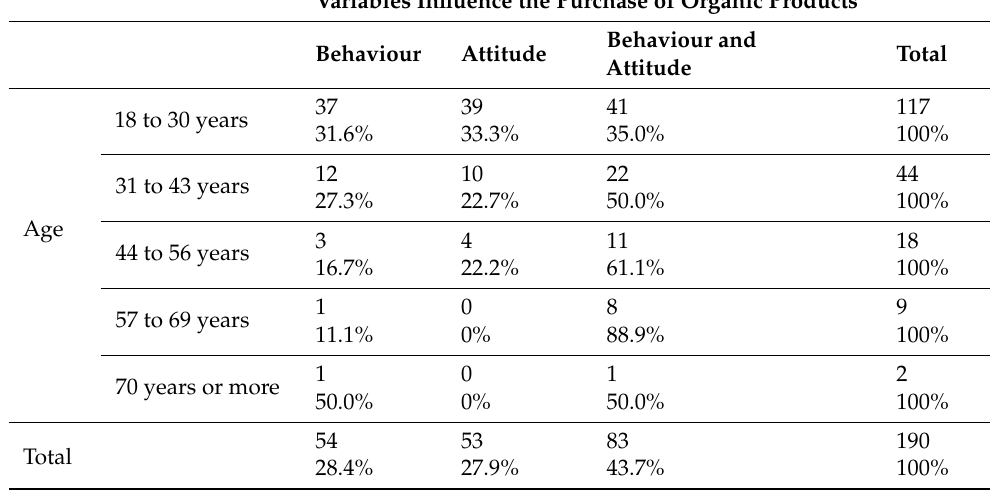
Table 1. Association between age and consumer behaviour and attitude.